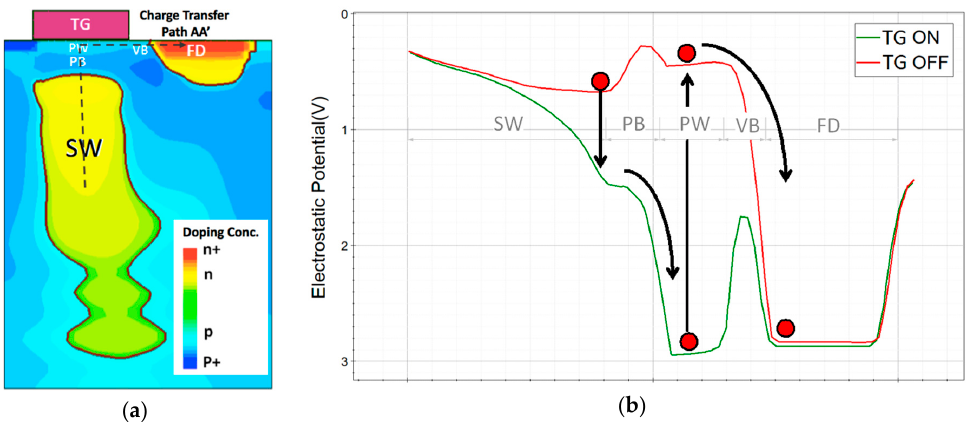
Figure 9. ( a ) PG jot cross-section doping profile from TCAD simulation; ( b ) Electrostatic potential curve along charge transfer path AA’. Both are presented in [13].